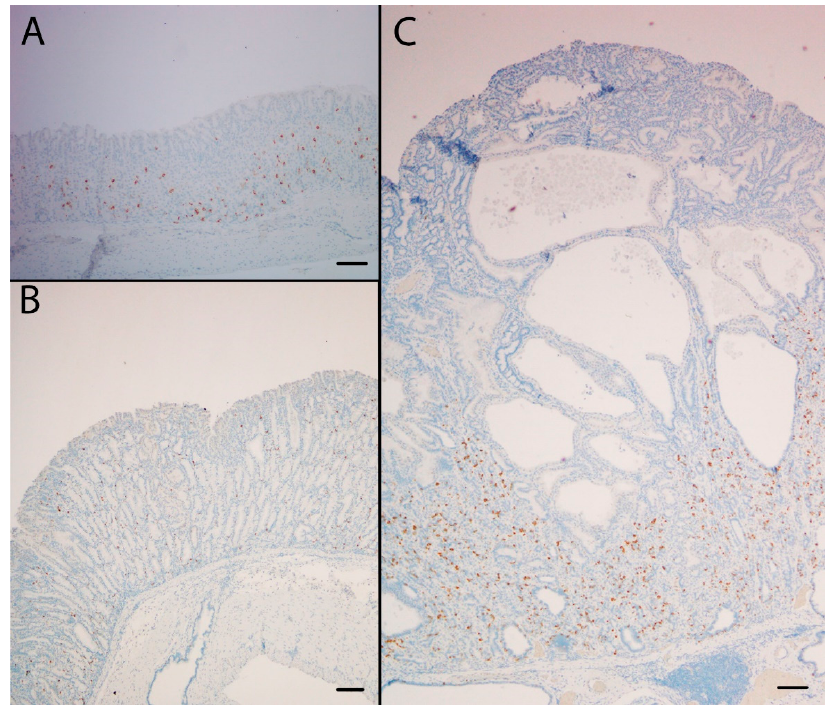
Figure 5. The NE marker CgA was highly expressed in the oxyntic mucosa of KO / PEG mice ( C ) compared to WT / PEG mice ( A ). Hyperplasia of NE cells in KO mice was reduced by NTZ in KO / NTZ mice ( B ). Scare Bar = 100 µ